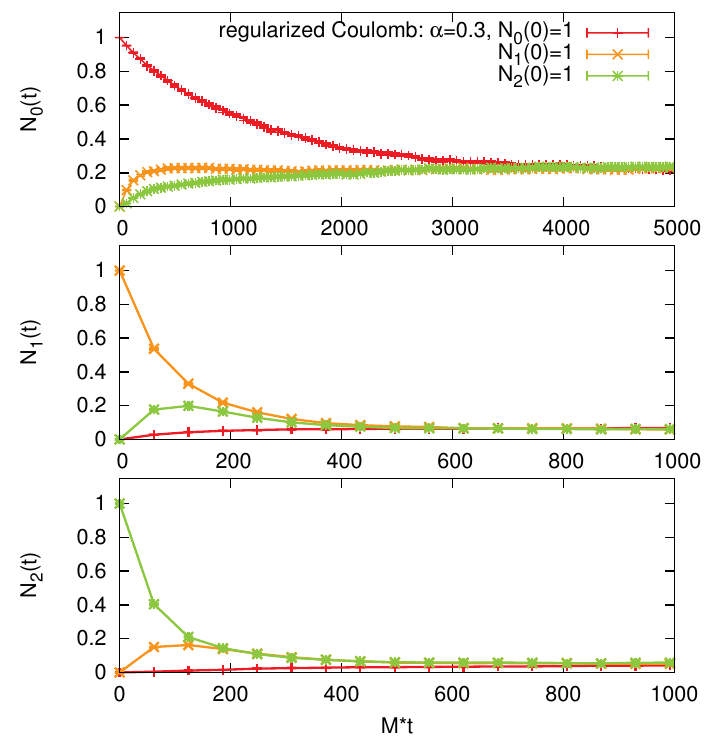
Figure 4 . Time evolution of the occupation number of the eigenstates in the regularized Coulomb potential with (cid:11) = 0 : 3 and r c = 1 =M . The bars denote statistical errors.